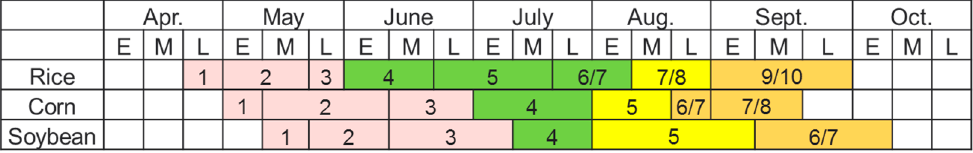
Figure 2. Crop calendars for the three major crops (corn, rice, and soybean) in the Sanjiang Plain [30,31]. We divided a month into three parts (e.g., early April (E), middle April (M), and late April (L)). Rice: 1, sowing; 2, seeding / flooding; 3, transplanting; 4, reviving; 5, tillering; 6, booting; 7, heading; 8, milk stage; 9, mature; and 10, harvest; Corn: 1, sowing; 2, seeding / three leaves; 3, seven leaves; 4,